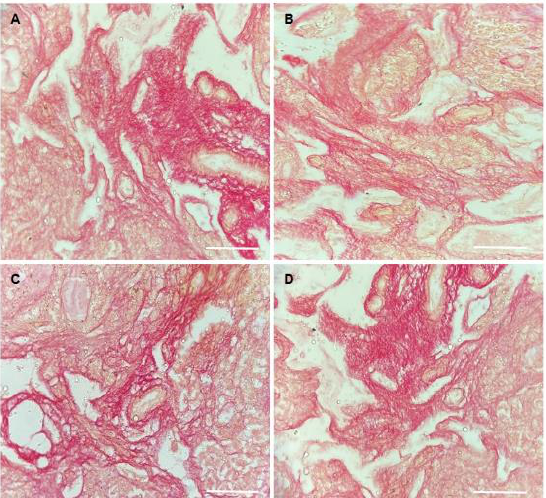
Figure 8. Representative images of collagen fibers labeled by Picrosirius red: ( A ) control group (DMEM + ); ( B ) DOXO (0.3 μg /mL); ( C ) CIMI (5 ng/mL) and ( D ) CIMI (5 ng/mL) + DOXO (0.3 μg /mL). Scale bar: 100 μm (400 ×).